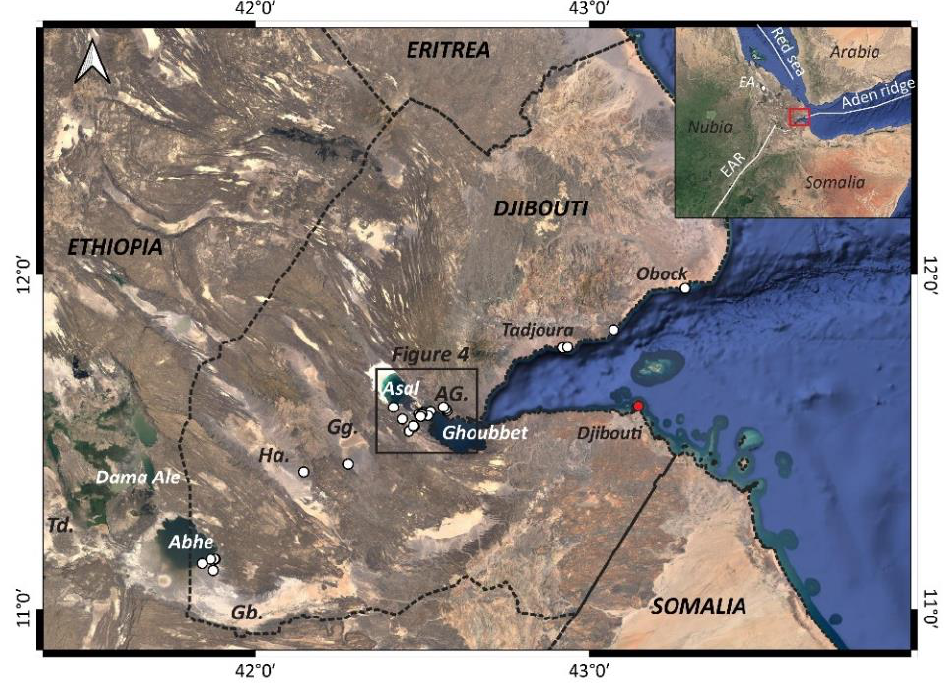
Figure 3. Satellite map illustrating the 3 main axes of the Afar Depression and a close-up on the Djibouti side showing sampling sites and major structures. EAR: East African Rift; AG: Asal–Ghoubbet graben; Gg: Gaggade graben; Ha: Hanle graben; Gb: Goba’ad graben; Td: Tendaho; EA: Erta Ale.